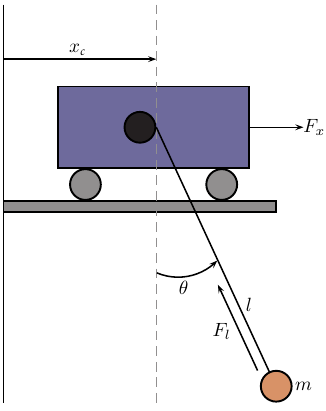
Figure 1. Three degrees of freedom mechanical 1